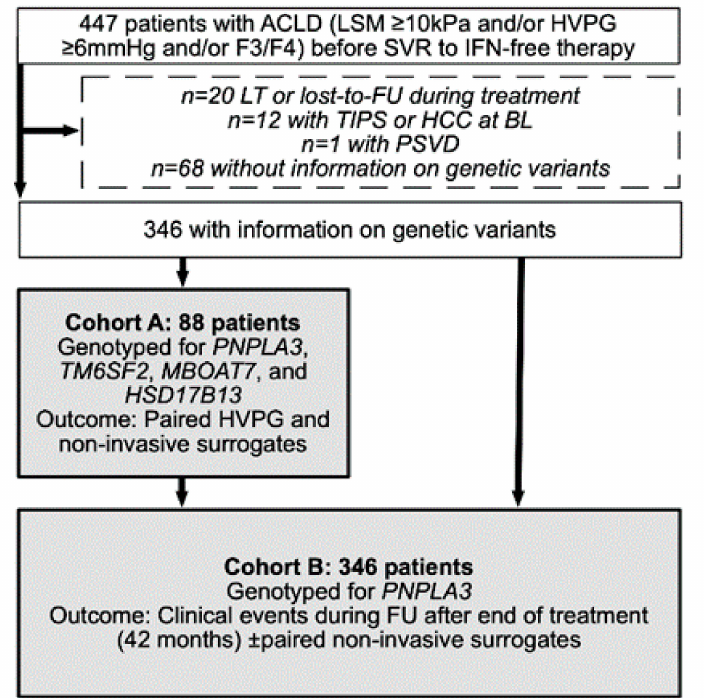
Figure 1. Study flow chart. Abbreviations: ACLD advanced chronic liver disease, FU follow-up, HCC hepatocellular carcinoma, HVPG hepatic venous pressure gradient, IFN interferon, LT liver transplantation, PSVD porto-sinusoidal vascular disease, SVR sustained virologic response, TIPS transjugular intrahepatic portosystemic